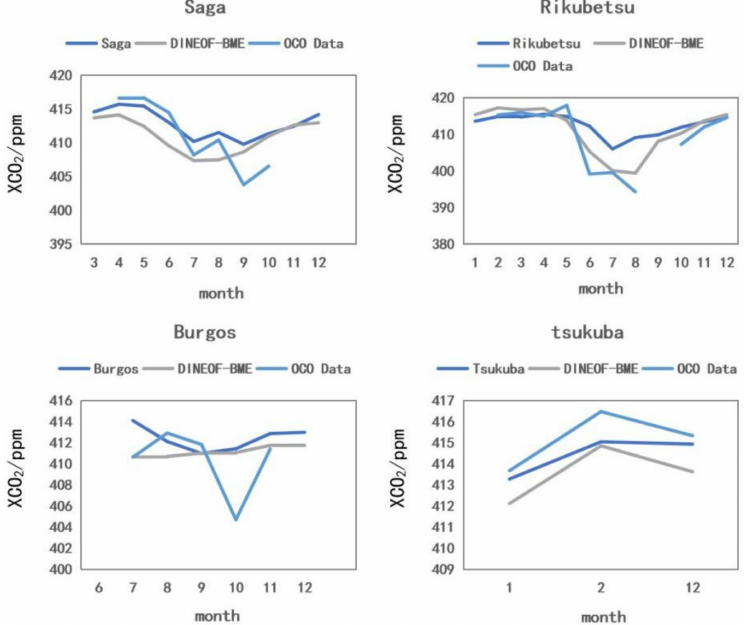
Figure 6. Line chart of the TCCON XCO 2 Measured Data Compared with the OCO XCO 2 Data and the Product of XCO 2 interpolated by the synthetic DINEOF–BME Approach (January–December 2020).